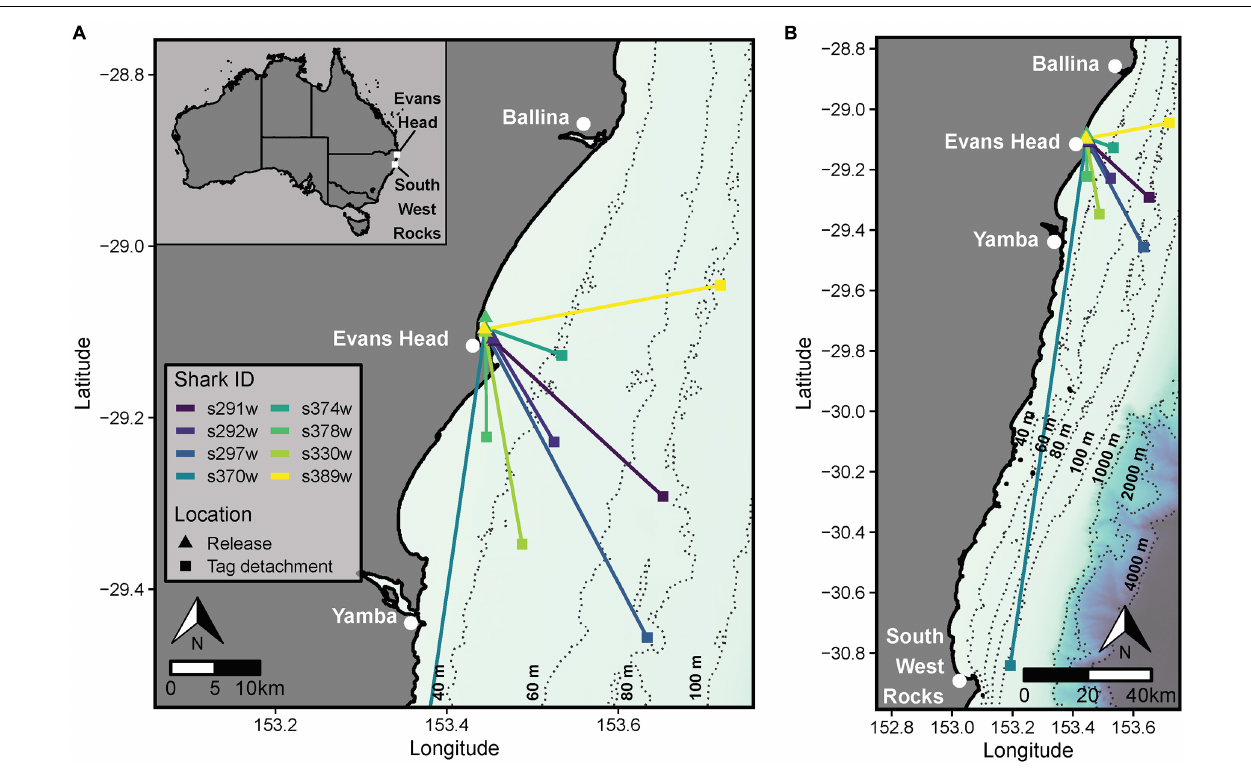
FIGURE 1 | (A) Vectors indicating the net linear displacement bearing and distance moved by sharks between the location of release from SMART drumlines at Evans Head and the detachment of the tag. (B) Long distance movement of shark s370w which had an extended deployment duration ( ∼ 136 h) relative to other sharks. The coastline shapefile and bathymetric data were sourced from the GSHHG Database (Wessel and Smith, 1996; available from https://www.ngdc.noaa.gov/mgg/shorelines/) and the GEBCO 2020 15 arc-second bathymetric grid (GEBCO Compilation Group, 2020; available from https://www.gebco.net/data_and_products/gridded_bathymetry_data/gebco_2020/).